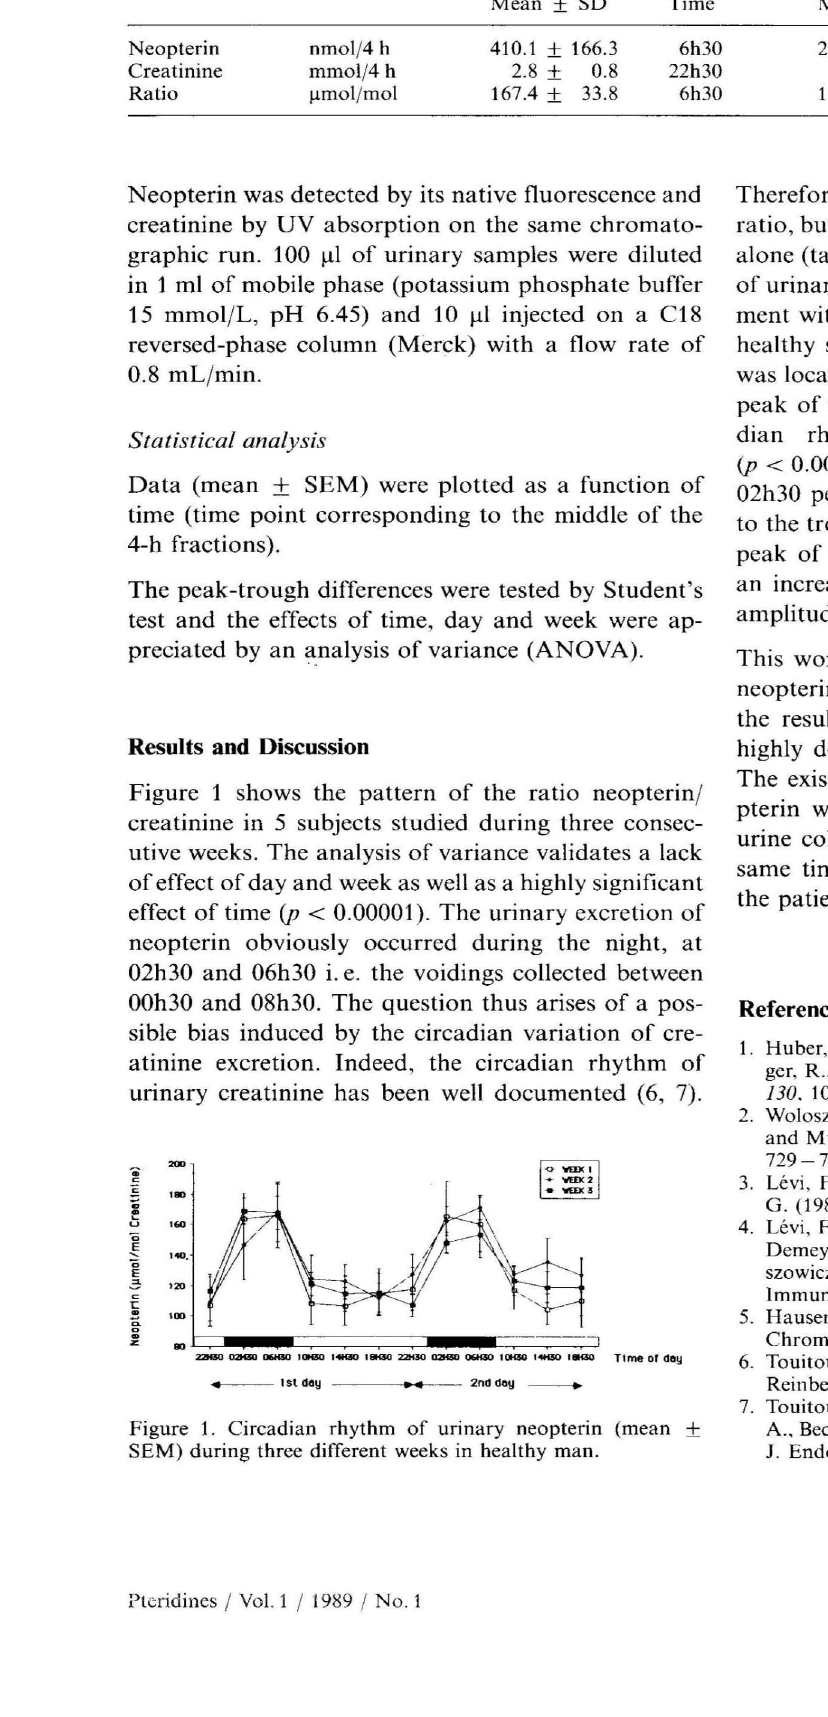
Table 1. Peak and trough differences in urinary neopterin in healthy man.